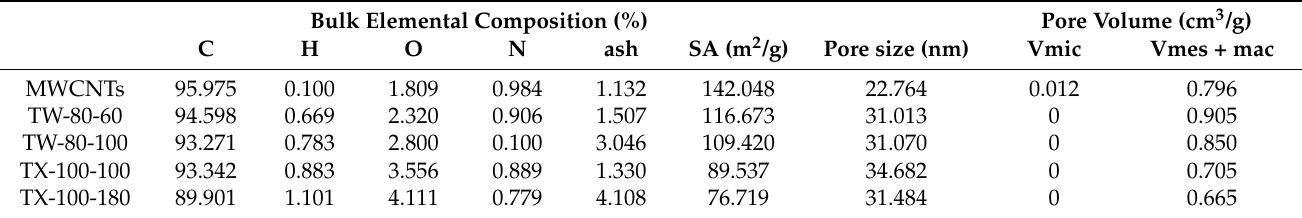
Table 4. Bulk elemental composition and pore volume of MWCNTs. Bulk Elemental Composition (%) Pore Volume (cm 3